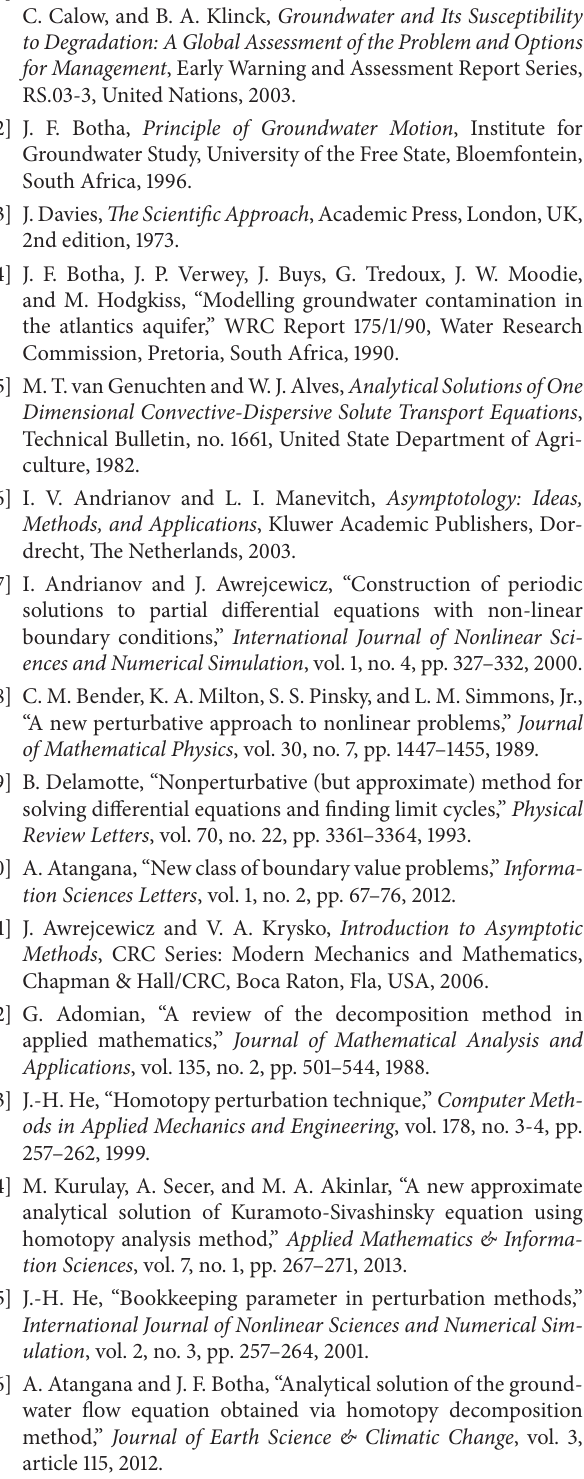
may (a) pass through the medium with no apparent effect, (b) be absorbed by the porous matrix, and (c) react with the porous matrix and other substances dissolved in the